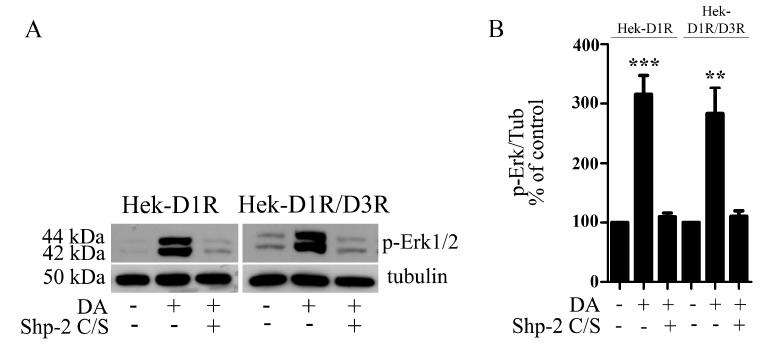
Figure 5. In Hek-D1R/D3R cells, activation of Erk1/2 induced with D1R and D3R co-stimulation requires the tyrosine phosphatase Shp-2. Hek-D1R and Hek-D1R/D3R cells were transiently trans- fected with a dominant negative form of Shp-2 (Shp-2 (C/S) and treated with DA (1 µ M) for 5 min, ( A ) a representative WB is shown; ( B ) densitometric analysis of blots (n = 4) with specific p-Erk1/2 levels normalized to the corresponding tubulin levels. Bars represent the mean ± S.E.M. *** p < 0.001, ** p < 0.01 vs. untreated cells. Data were statistically analyzed using one-way ANOVA followed by post hoc comparison with the Bonferroni test.